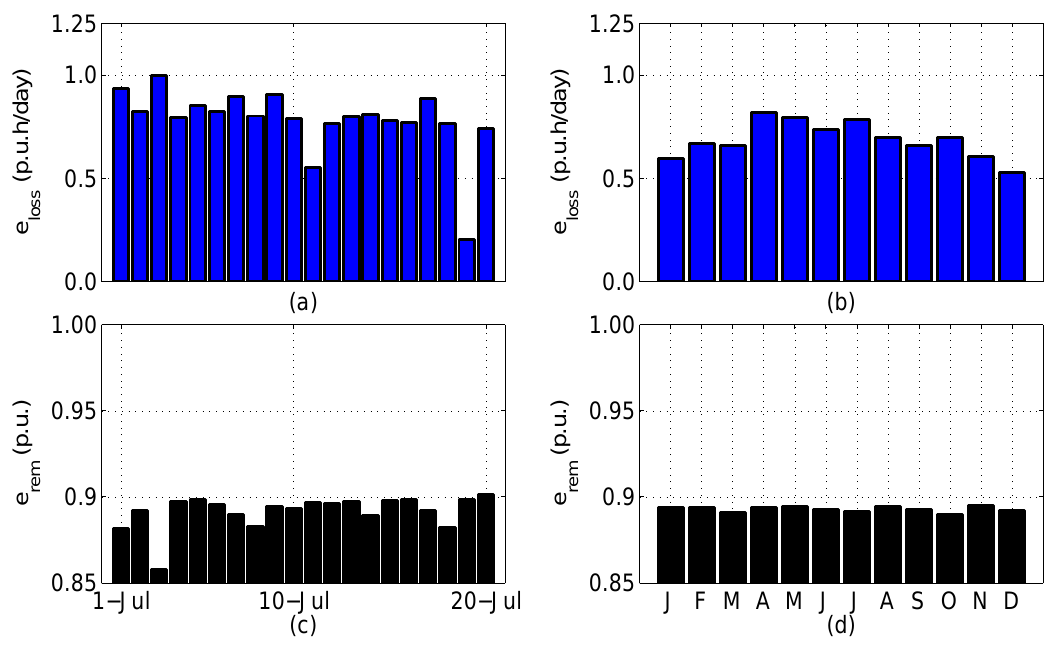
Figure 16. USPVP energy losses due to FR during a year in Puerto Rico: ( a ) Daily energy losses ( e loss ) in July; ( b ) monthly energy losses; ( c ) daily remnant energy ( e rem ) in July; and ( d ) monthly remnant